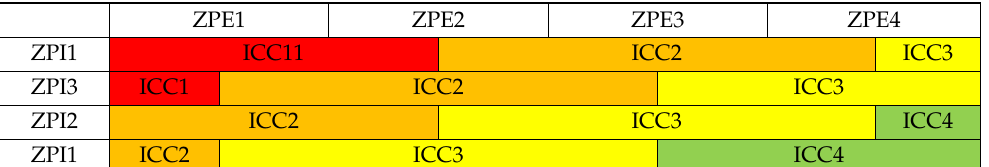
Table 5. Level of integrated coastal risk. The colours indicated the levels of flooding risk with red indicating very high flooding risk and green low flooding risk.